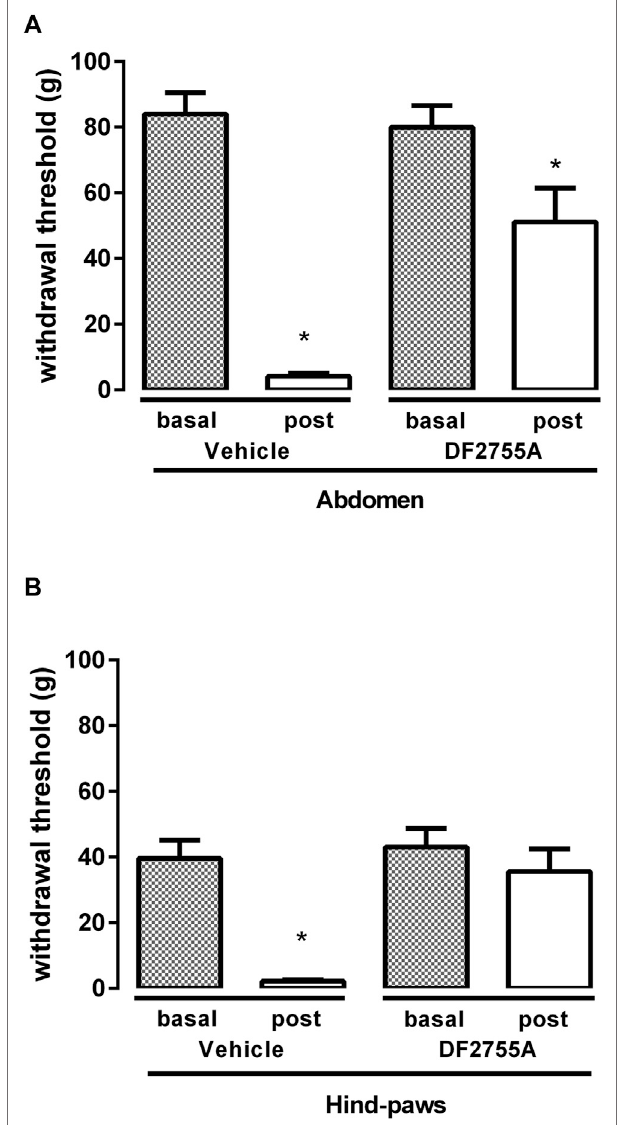
FIGURE 3 | DF2755A preventive treatment blocked peripheral neuropathy in experimental non-Hunner IC. Rats were orally treated with repeated vehicle or DF2755A (20 mg kg − 1 12 h before the fi rst CYP injection +7 mg kg − 1 twice daily for 7 days) administrations. Mechanical nociceptive threshold was measured on the abdominal area (A) or hind paw surfaces (B) before the fi rst CYP injection (Basal) and 24 h after the last CYP injection(Post).Datarepresentthewithdrawalthresholdandareexpressedas mean values ± SEM ( n = 10 per group) * p < 0.05 versus basal values (Student ’ s t test for paired data).